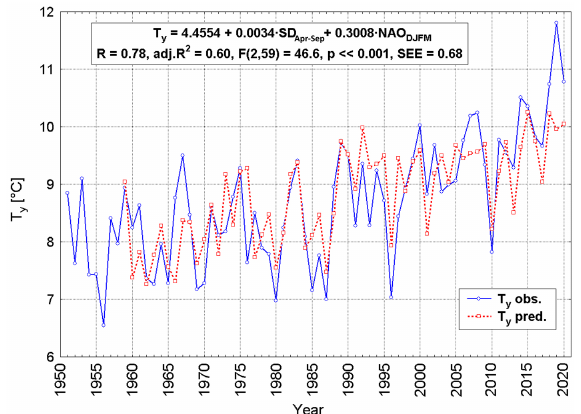
Fig. 7. The annual temperature observed (T obs.) y as a function of SD of the warm half-year (variable SD ) and the winter PC-based NAo Hurrell Apr-Sep index (variable NAo ). NAO, North Atlantic DJFM oscillation; SD, sunshine